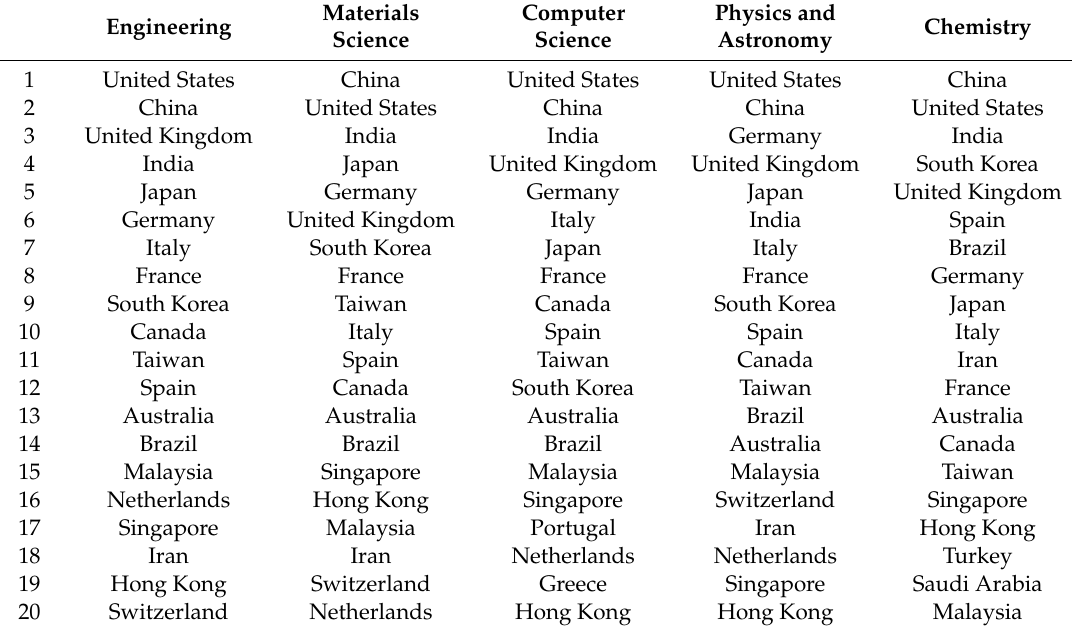
Table 2. Worldwide publications by country on low cost for the top five